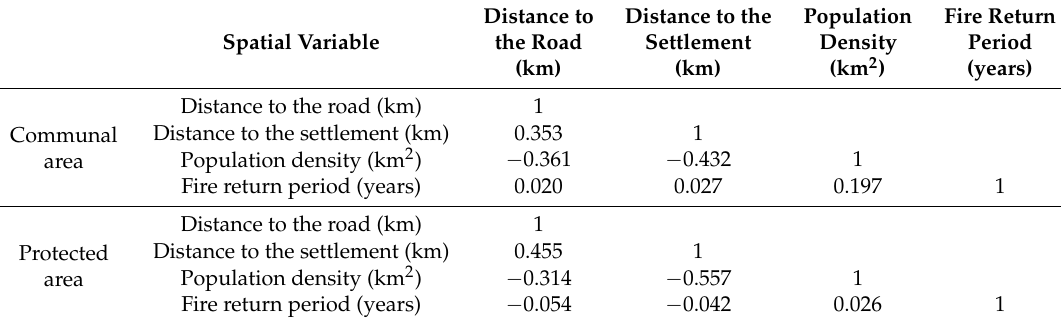
Table 5. Correlation matrix for explanatory